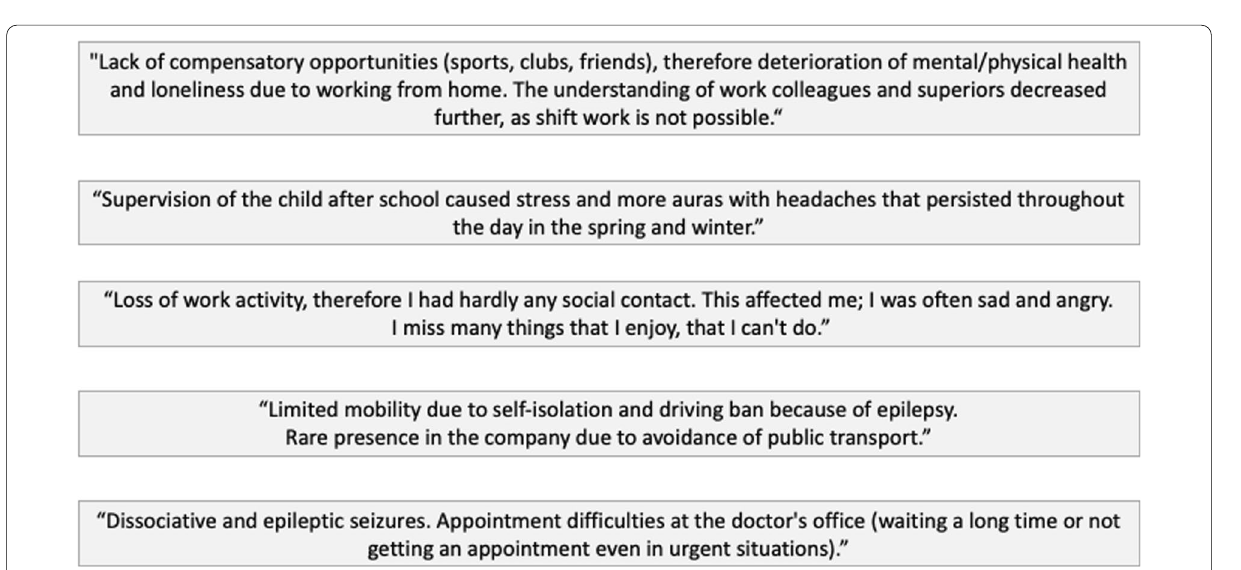
Fig. 4 Examples of free‑text responses and reactions to the first wave of the COVID‑19 pandemic reported by PWE